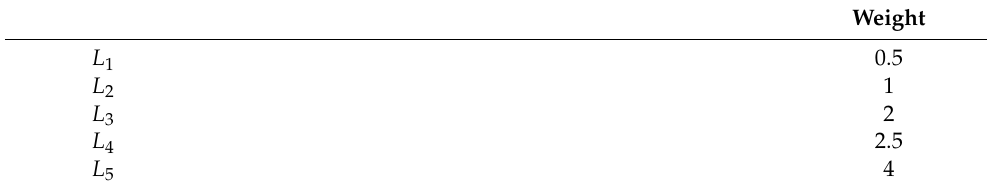
Table 6. State weight value.